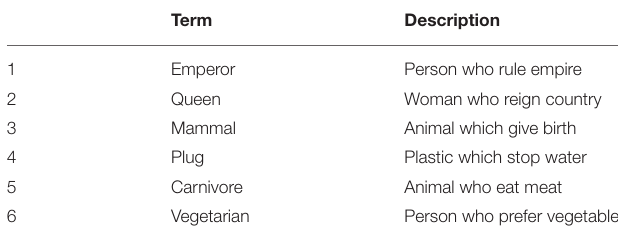
TABLE 7 | Examples from a Term-Description dataset, cited from Sadrzadeh et al.